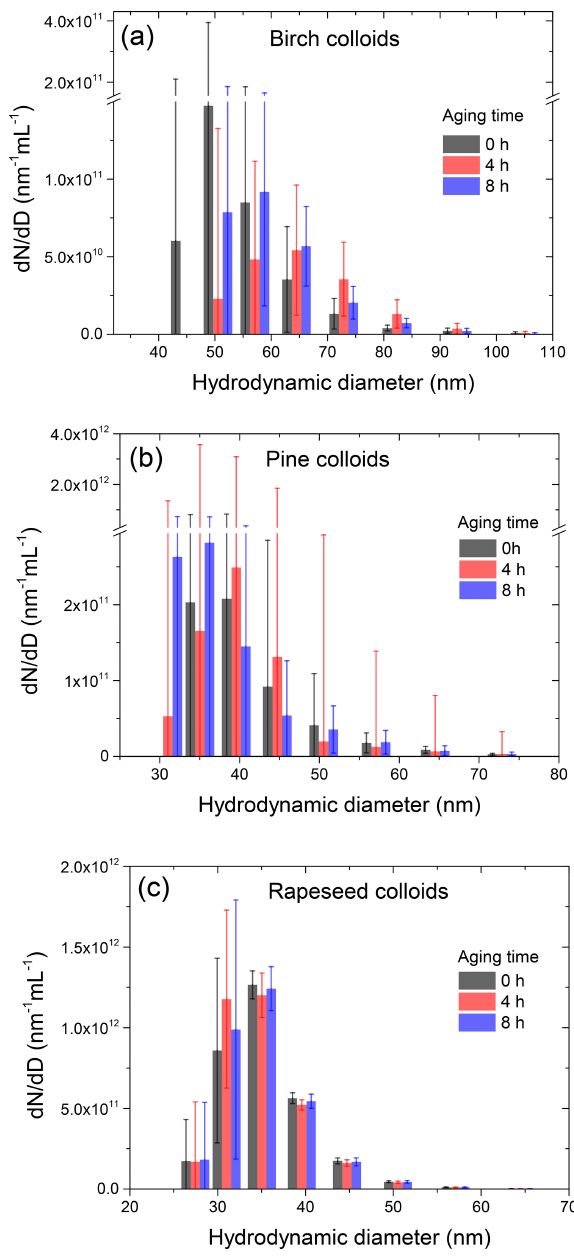
Figure 2. Colloidal particle number size distributions of aqueous extracts of birch (a) , pine (b) , and rapeseed (d) pollen grains: initial (0h) and after 4 and 8h